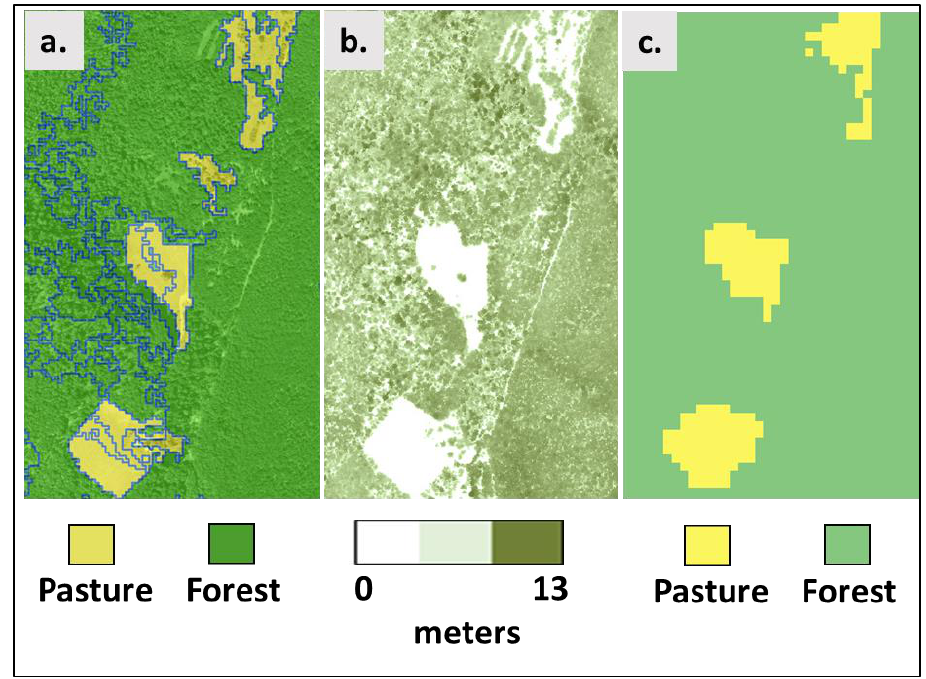
Figure 3. Comparison of different uses of National Agriculture Imagery Program (NAIP) for forest resource measurement and mapping with Landsat-based classification. ( a ) A NAIP image with an image segmentation applied (blue polygonal areas) and an object-based image analysis (OBIA) classification algorithm applied to the polygons (yellow is nonforest, green is forest); ( b ) a pixel-based tree height classification of NAIP imagery; ( c ) A Landsat-based forest/nonforest classification.